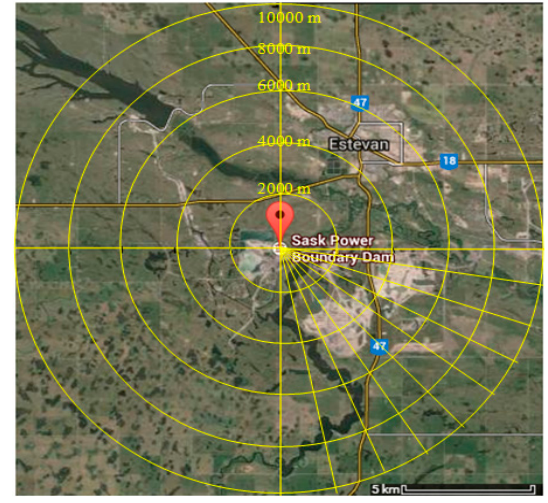
Figure 3. Location of air dispersion study area and receptor network specification.